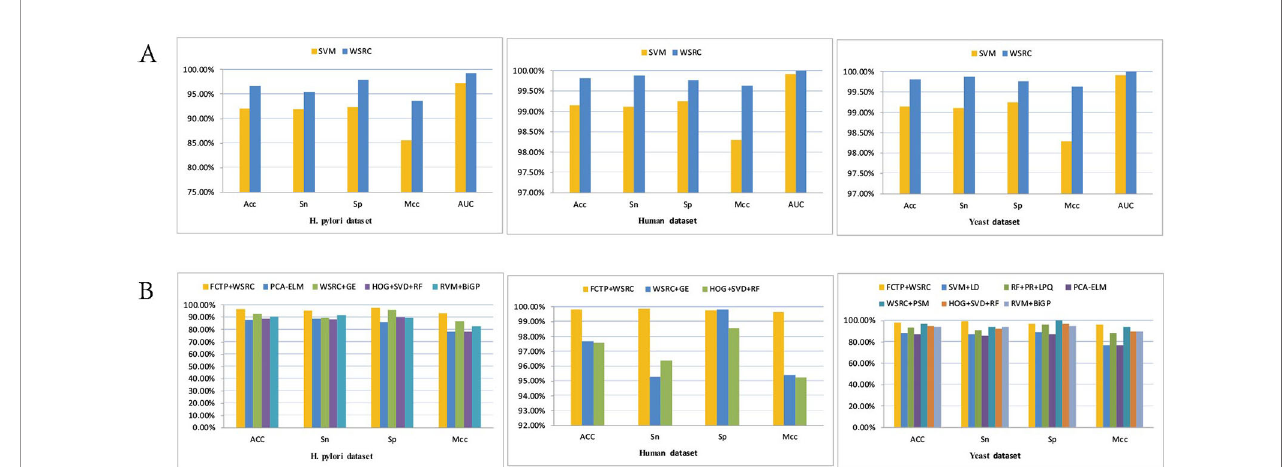
FIGURE 5 | (A) Results using FCTP encoding on the H. pylori, Human and Yeast datasets with different classi fi ers. (B) Results using different methods on three datasets.